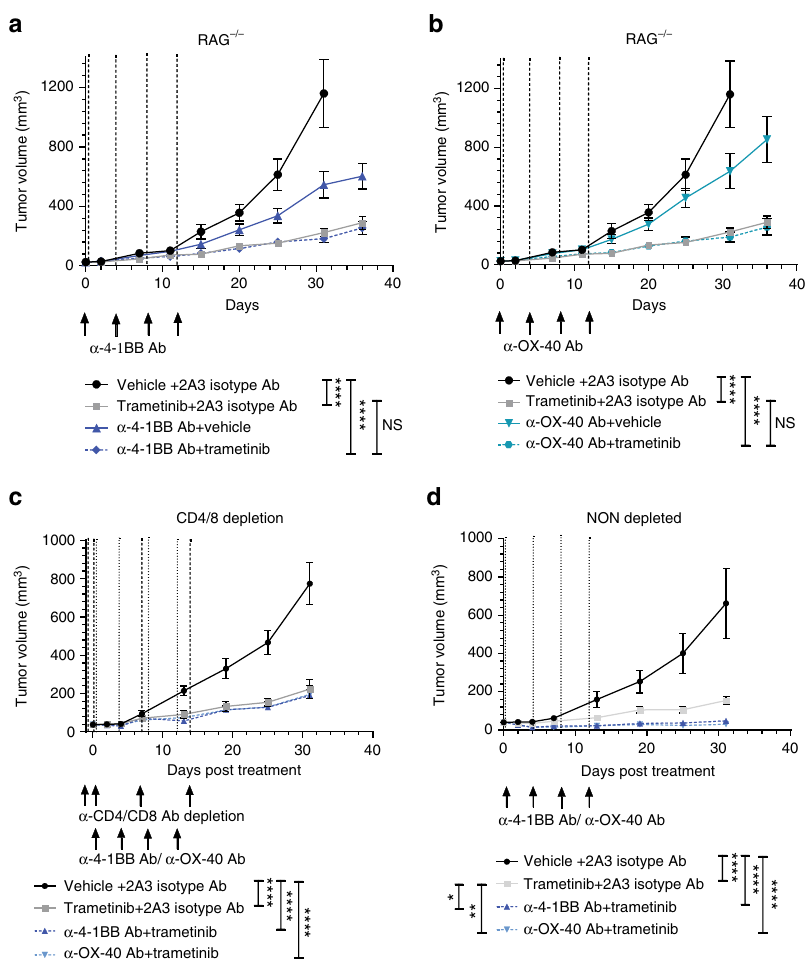
Fig. 9 MEK inhibition and agonist combination therapy in RAG and T-cell depletion models demonstrates the functional role of T cells in enhancing therapeutic responses. a , b RAG − / − mice ( n = 8 per group) bearing established AT3ova tumors were treated with vehicle or trametinib via daily oral gavage for 20 days (AT3ova) and either 2A3 isotype control, α -4-1BB, or α -OX-40 antibody alone; four doses (AT3ova) via IP injection on days 0, 4, 8, and 12 or combination of trametinib and agonists. c WT C57BL/6 mice ( n = 6 per group) bearing established AT3ova tumors were concurrently depleted of CD4